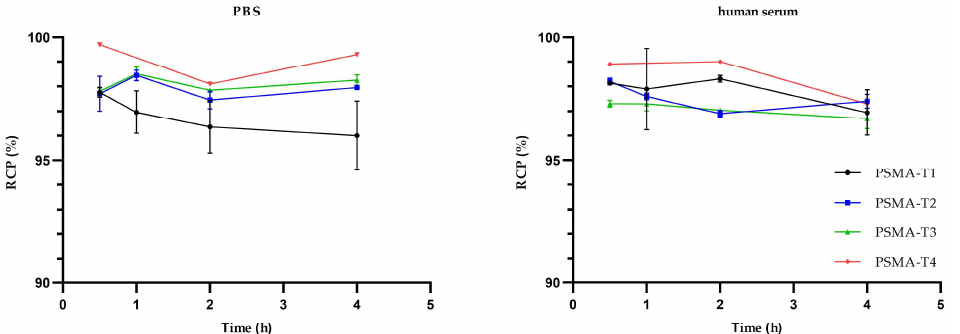
Figure 3. Stability of 99m Tc-labelled PSMA-HYNIC compounds in PBS and human serum at 37 ◦ C. The study on the lipophilicity of the technetium-99m labeled PSMA ligands showed that due to use of tryptophan (L-Trp) in the structure of the linker instead of naphthylala- nine (L-2NaI), PSMA-T3 and -T4 are more hydrophilic than PSMA-T1 and -T2 analogues, which logD values are comparable with reference [ 99m Tc]Tc-iPSMA [35], Table 2. Table 2. Comparison of lipophilicity of PSMA radiocomplexes.